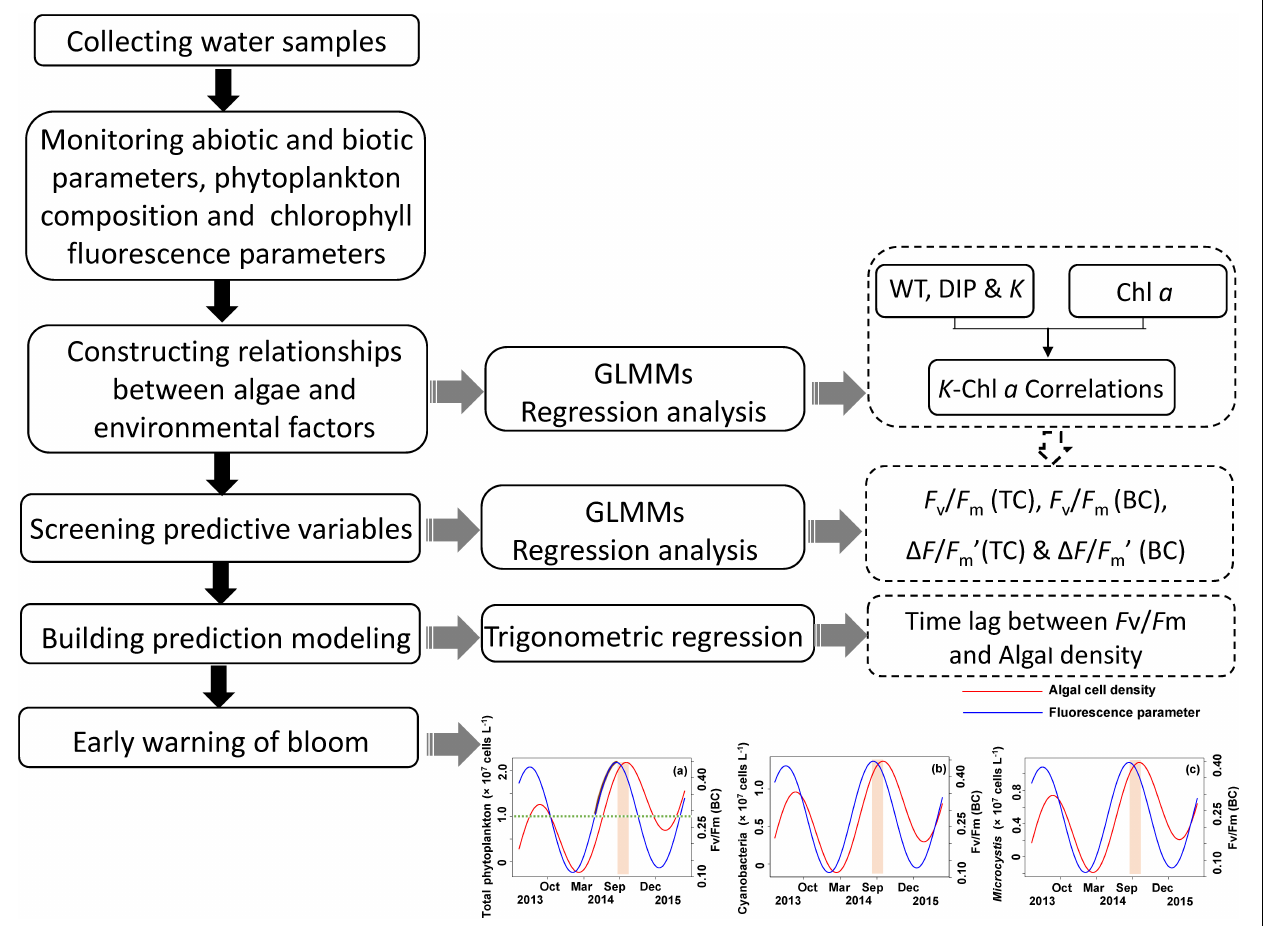
FIGURE 2 | Technique flow diagram of the application of method early warning the algal cell density and Microcystis bloom by measuring chlorophyll fluorescence F v / F m